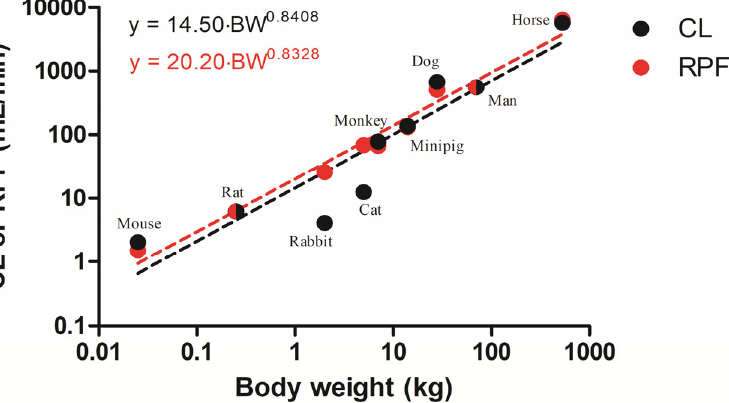
Figure 1. Allometric relationships between literature-reported metformin CL (black) and renal plasma flow ( RPF ) values (red) and body weights of 9 species (Table 3, see below). Except for rabbit and cat, the systemic clearance of metformin was comparable to RPF . Lines were fitted to the indicated allometric relationships ( y = a · BW b , where BW is the body weight).